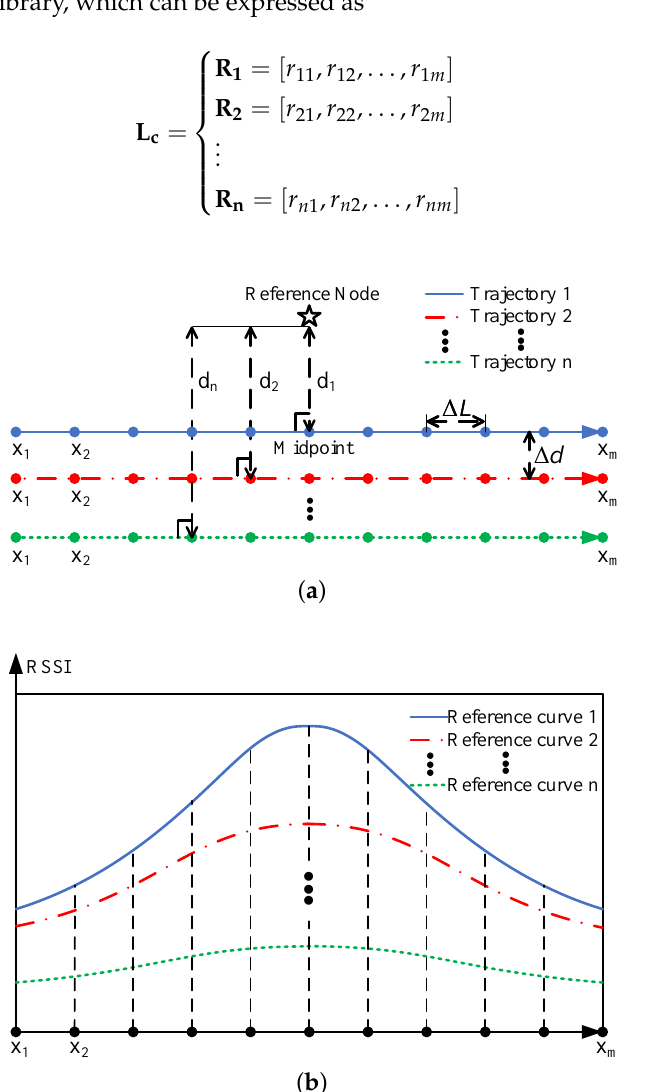
Figure 7. The establishment of the reference RSSI curve library: ( a ) the positional relationship between the reference node and n trajectories; and ( b ) the reference RSSI curve